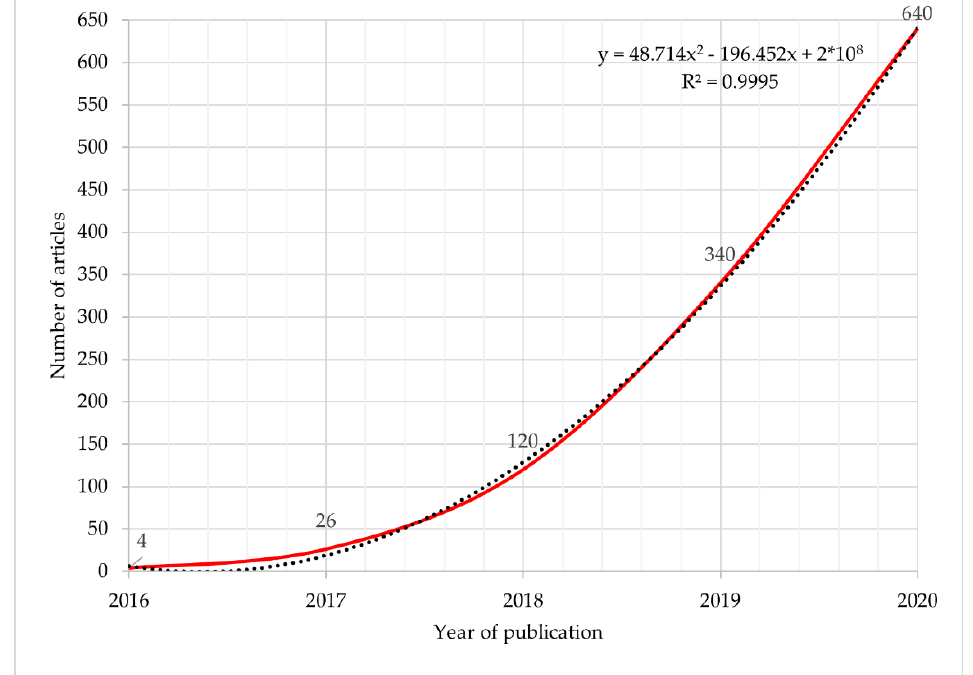
Figure 2. Evolution of Scientific Production (2016–2020).